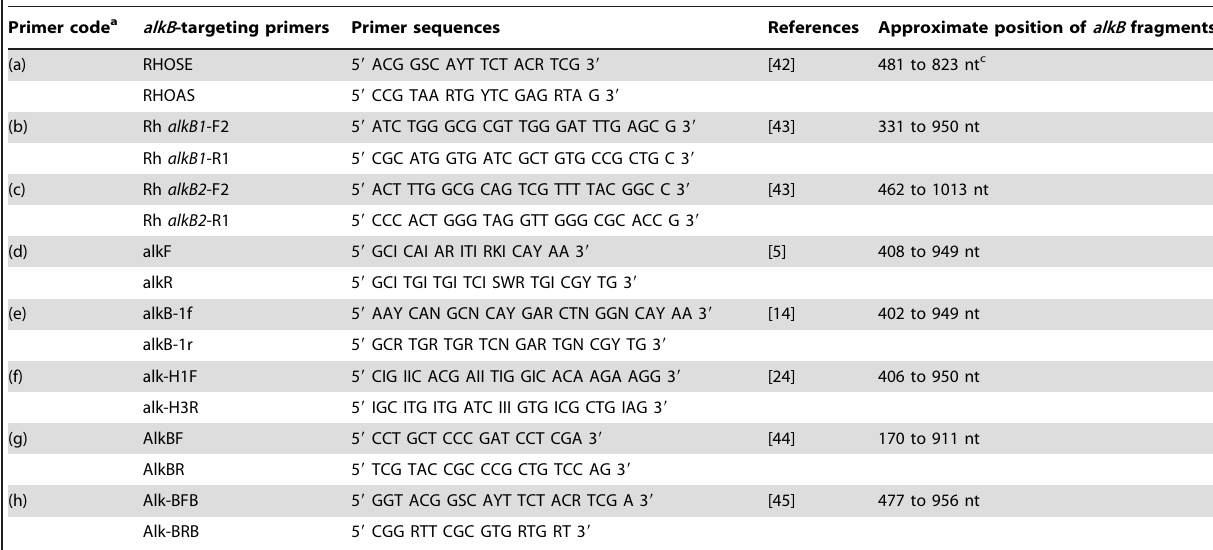
Primer code a alkB -targeting primers Primer